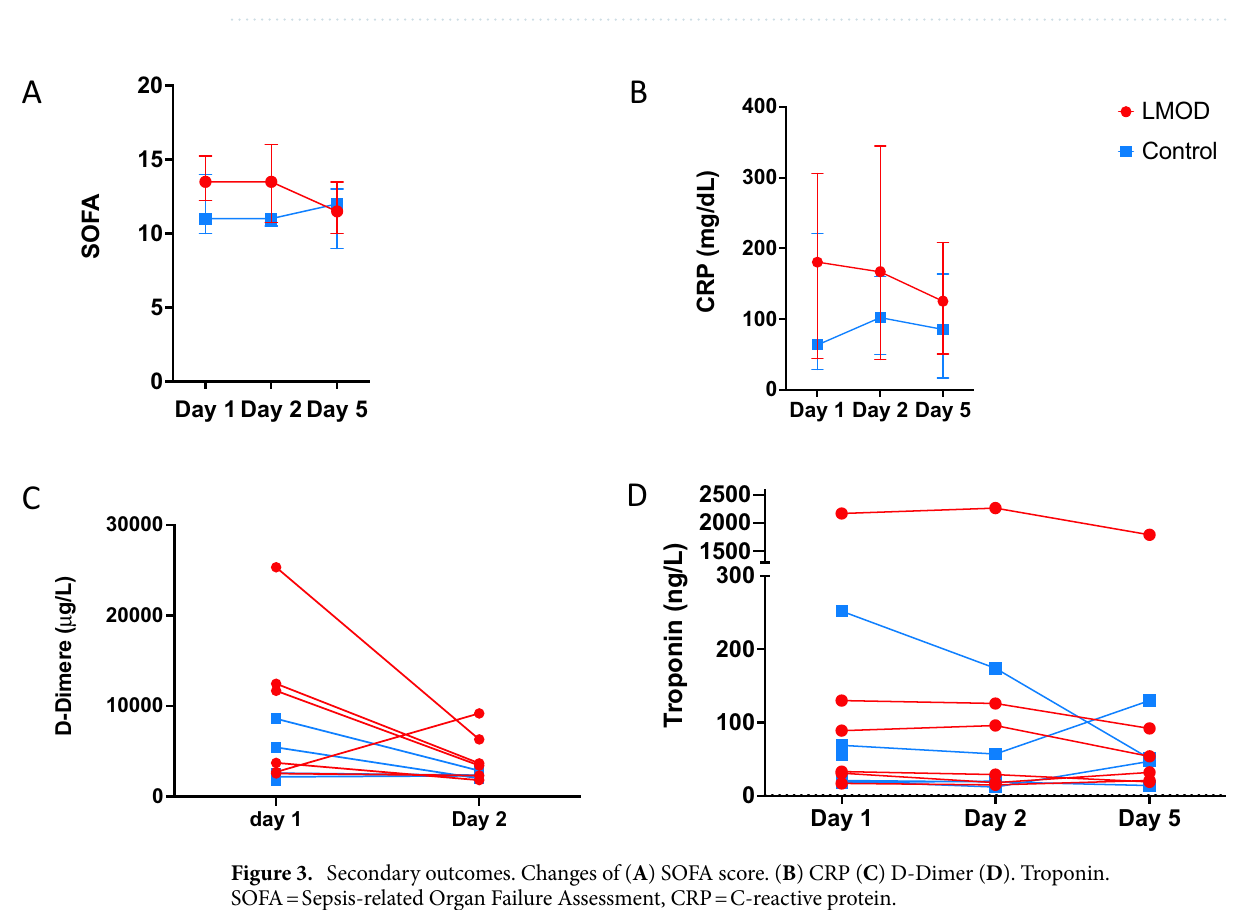
Figure 3. Secondary outcomes. Changes of ( A ) SOFA score. ( B ) CRP ( C ) D-Dimer ( D ). Troponin. SOFA = Sepsis-related Organ Failure Assessment, CRP = C-reactive protein.